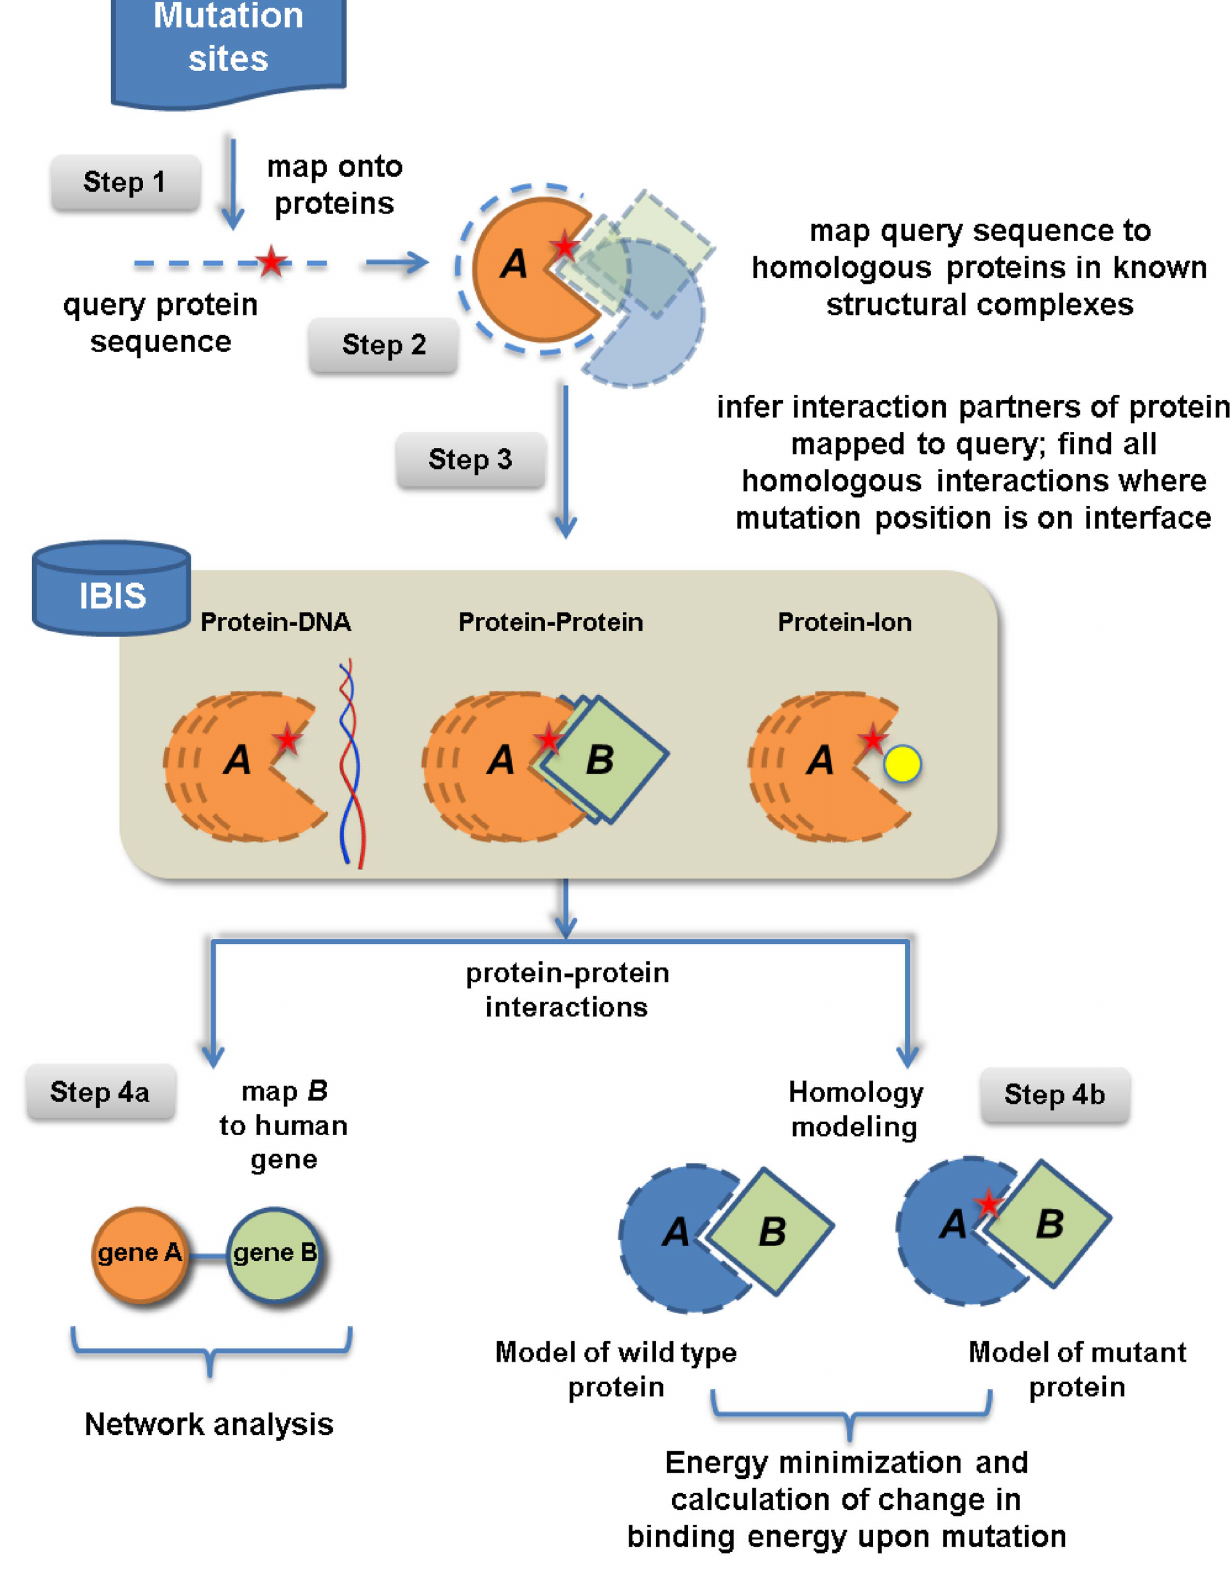
Figure 1. Mapping the human interactome and glioblastoma mutations on binding interfaces. In step 1 we mapped 695 missense mutations from 598 human genes to protein sequences. Subsequently, query protein sequences were aligned to homologous, experimentally determined structural complexes (step 2), allowing us to infer query-specific interactions with other proteins, nucleic acids and ions (step 3). For